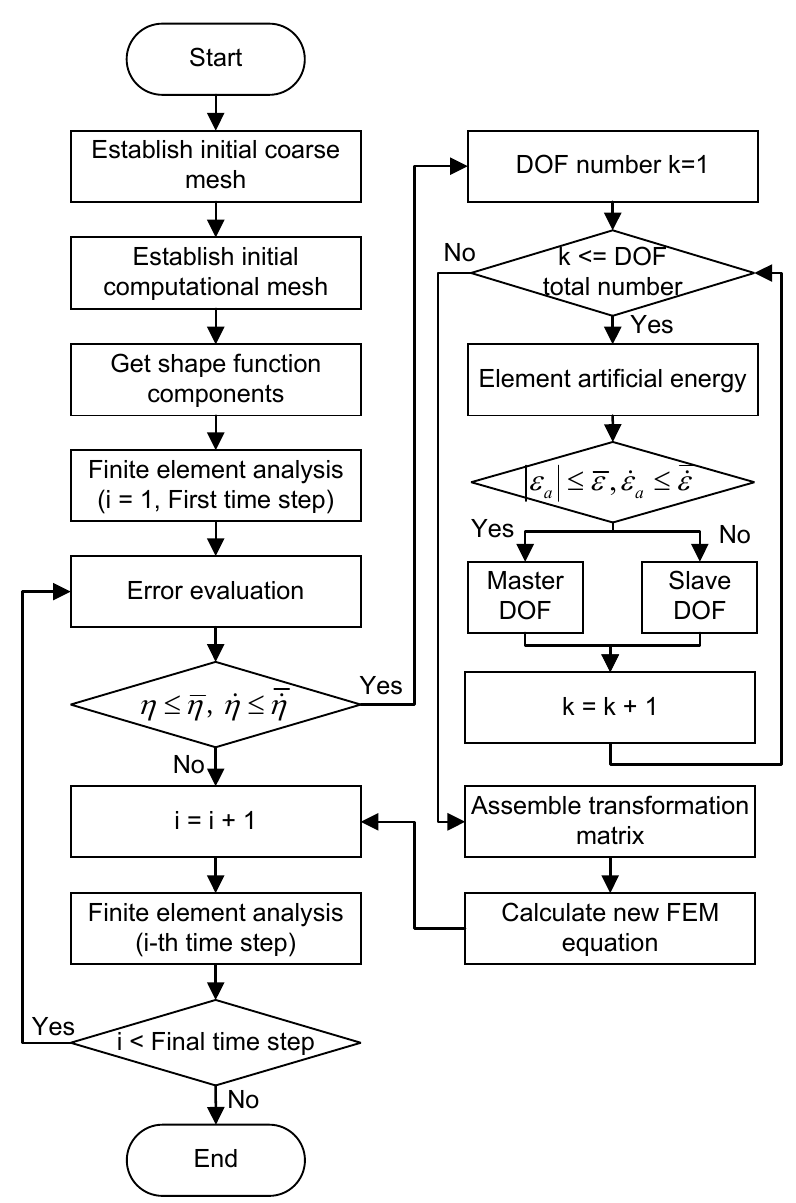
Figure 2. Flow diagram of